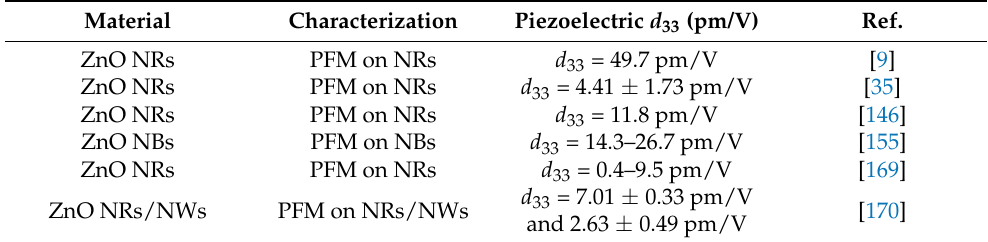
Table 4. Piezoelectric coefficient d 33 and characterization of ZnO nanostructures using PFM analysis. Material